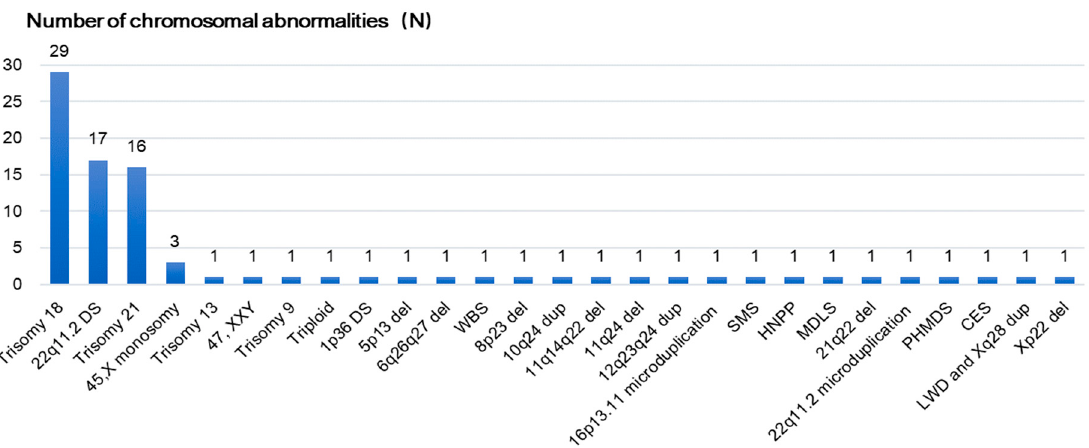
Figure 1. A detailed distribution map of chromosomal abnormalities. DS: deletion syndrome; del: deletion; dup: duplication; WBS: Williams-Beuren syndrome; 16p13.11 microduplication: 16p13.11 recurrent microduplication syndrome; SMS: Smith-Magenis syndrome; HNPP: Hereditary Liability to Pressure Palsies; MDLS: Miller-Dieker lissencephaly syndrome; 22q11.2 microduplication: 22q11.2 microduplication syndrome; PHMDS: Phelan-McDermid syndrome; CES: Cat eye syndrome; LWD: Leri-Weill